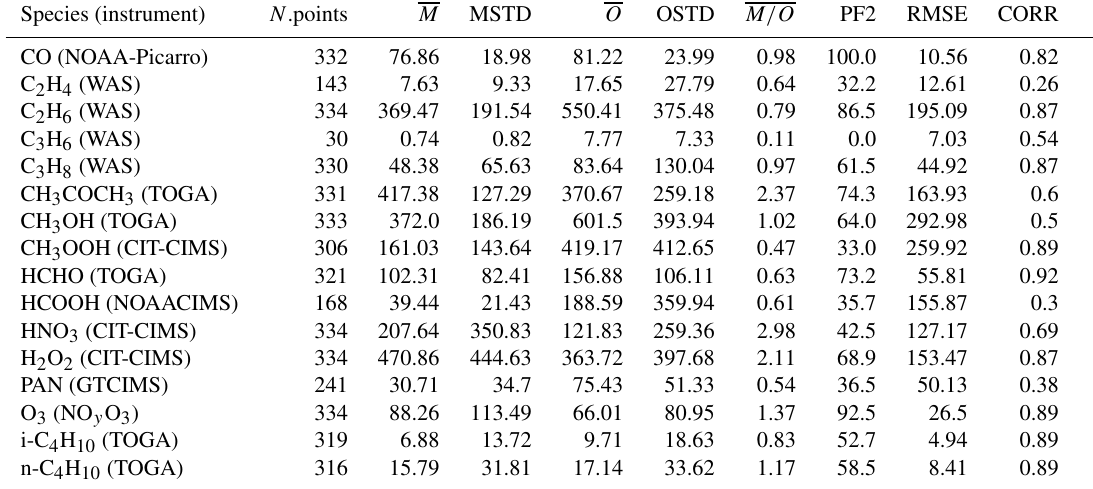
Table 2. Summary of simulated and observed mixing ratios of different tracers from the ATom campaign (Wofsy et al., 2021). N .points is the number of points used for the statistical estimation. The arithmetic mean of the model simulated mixing ratios ( M ), the observed mixing ratios ( O ) and the corresponding standard deviations (MSTD, OSTD) (in pmolmol − 1 ) are listed in the subsequent columns (for CO and O 3 units are nmolmol − 1 ). PF2 denotes the percentage of simulated points within a factor of 2 with respect to the observations, and RMSE represents the root-mean-square error between simulated and observed points. CORR is the Pearson correlation coefficient.